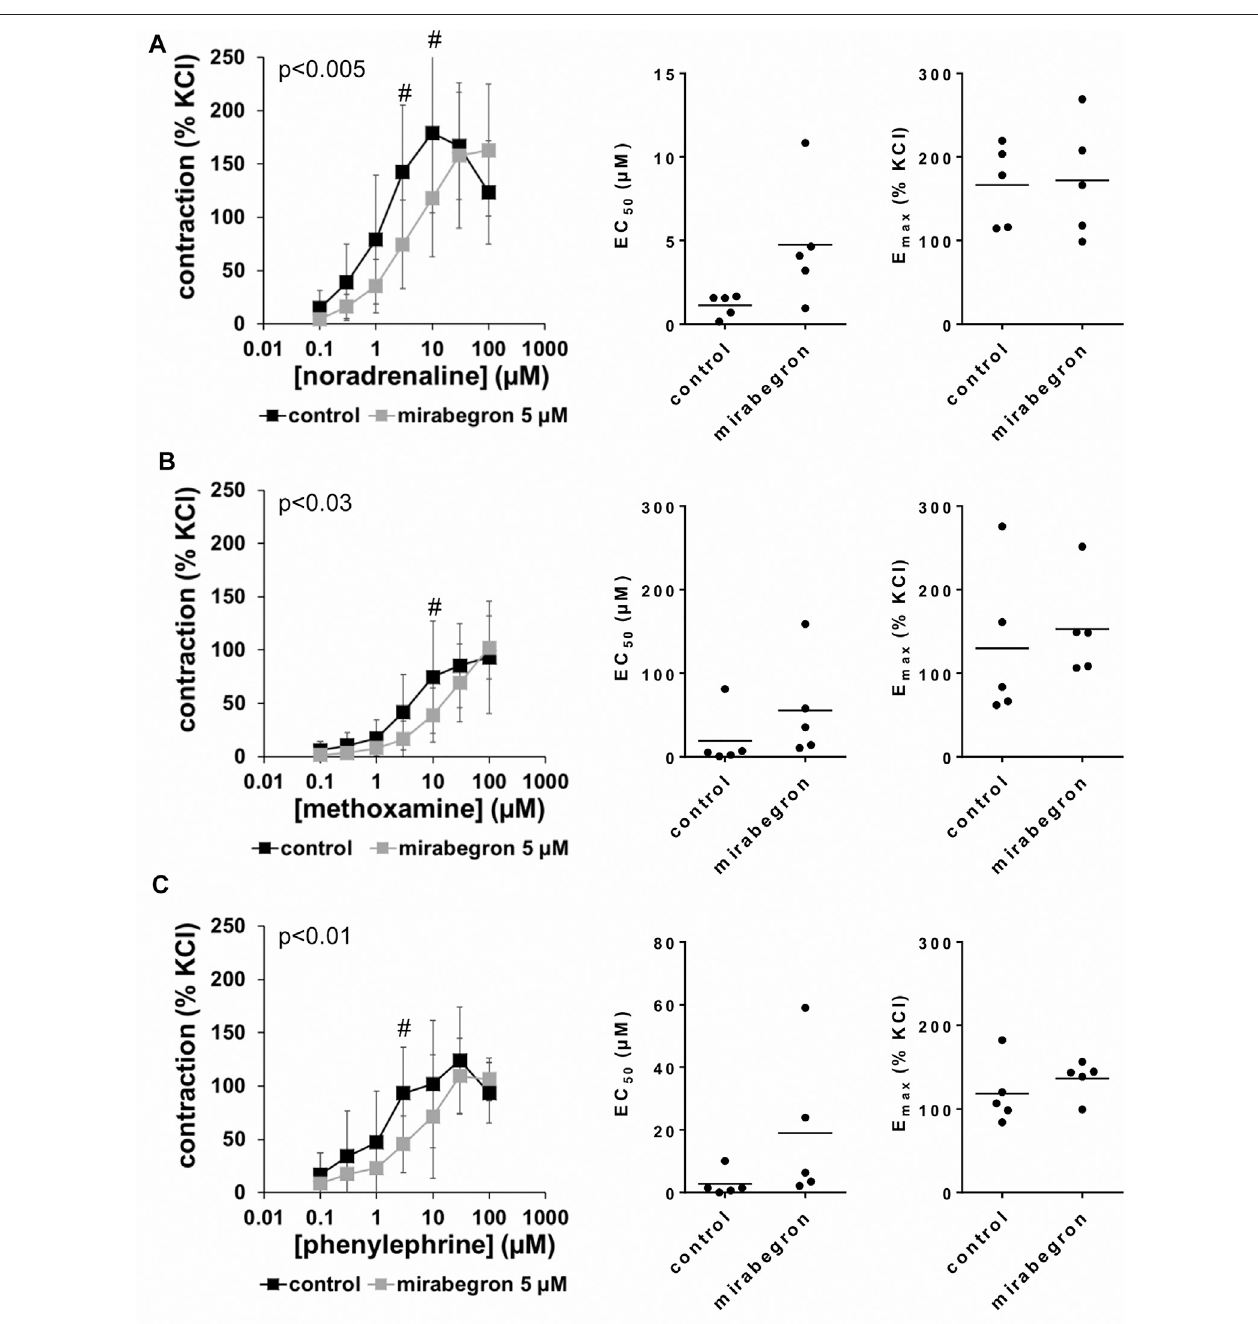
FIGURE3 | Effects of5 µM mirabegron on α 1 -adrenergic contractionsof human prostate tissues. Contractionsofprostate tissuesfrom the periurethral zone were inducedbycumulativeconcentrationsofnoradrenaline (A) ,methoxamine (B) orphenylephrine (C) inanorgan bath, 30 minafter addition ofmirabegron oranequivalent amount of DMSO (controls), which was used as solvent for mirabegron. Shown are data from n (cid:1) 5 patients in each diagram, which are means ± SD in frequency responsecurves(# p < 0.05forcontrolvs.mirabegronbytwo-wayANOVA,and p valuesforwholegroupsininsertsfrom1-wayANOVA),andE max andEC 50 values for single experiments (calculated by curve fi tting) in scatter plots.